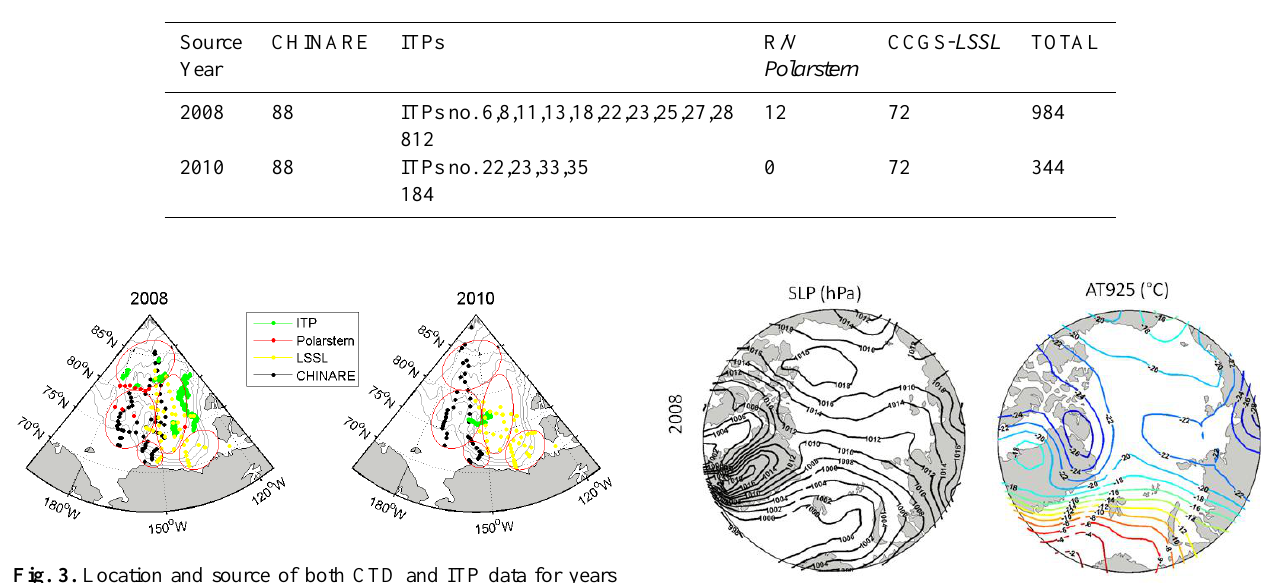
Table 1. Number of CTD stations by year and source used for this study, on summertime (from 1 July to 30 September), in the region 120–180 ◦ W of the Arctic Ocean.